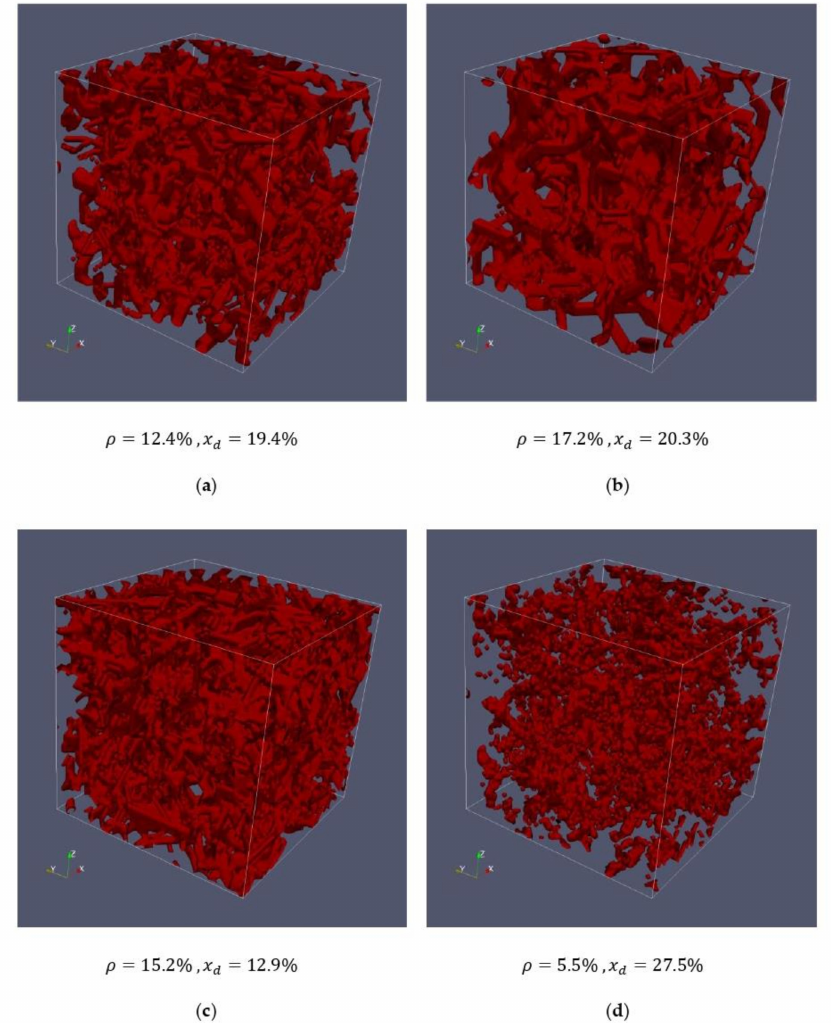
Figure 6. created actin networks in full size: ( a ) artificially generated network #1, ( b ) artificially generated network #2, ( c ) artificially generated network #3, ( d ) artificially generated network